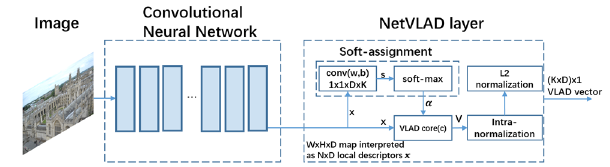
Figure 4. NetVLAD network structure.